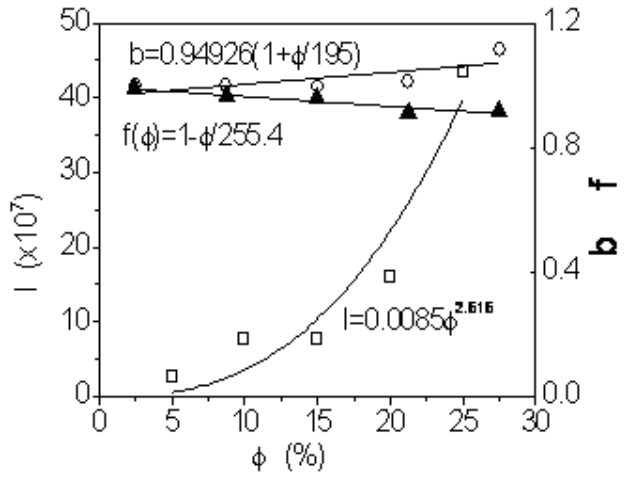
/ iPP and b , l for iPP/uncoated Ca 3